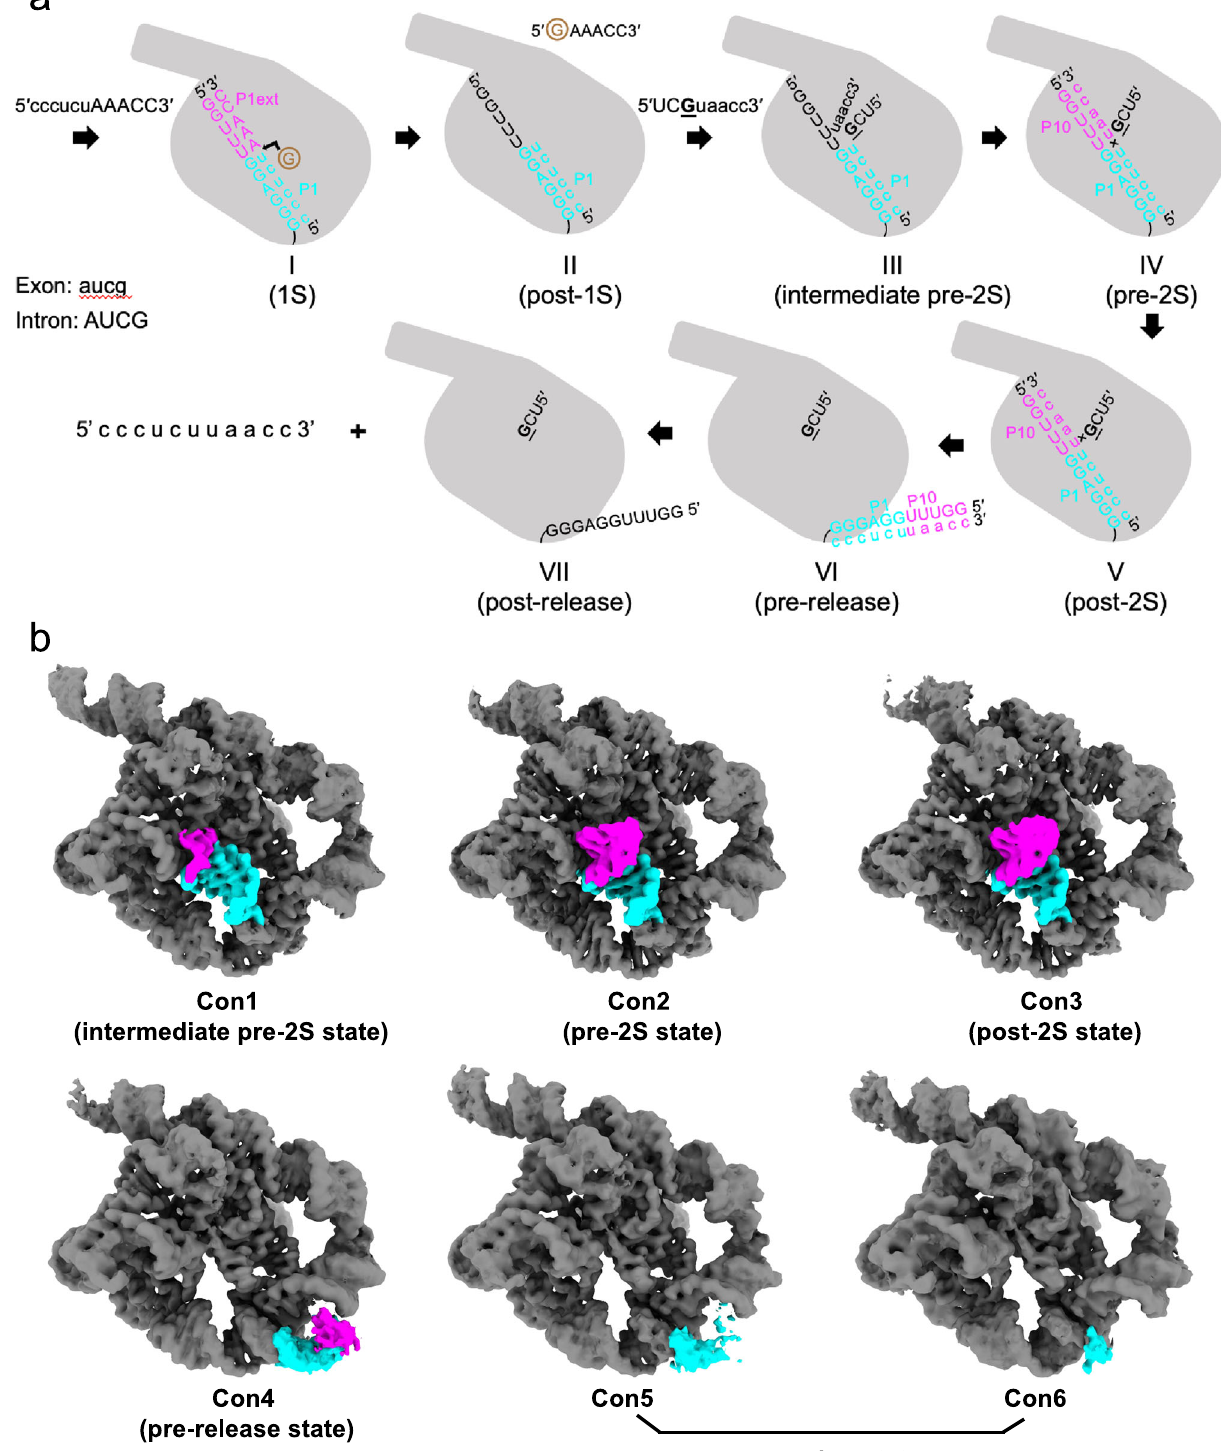
Fig. 1 | Snapshots of the self-splicing of Tetrahymena ribozyme revealed by cryo-EM.a Cartoonmodeloftheself-splicingreactionofL-16ScaIribozyme.Inthe fi rst transesteri fi cation reaction (I to II), an exogenous G (shown in brown) attacks the phosphodiester bond atthe 5 ′ -splice site in P1, leading to a free 3 ′ -OH group at theupstreamexonandtheexogenousGbeingattachedtothe5 ′ -endoftheintron. Then the 3 ′ -splice site substrate G (shown in G) replaces the exogenous G in the G-binding site (III), and the 3 ′ -exon is aligned in P10 for ligation (IV). In the second